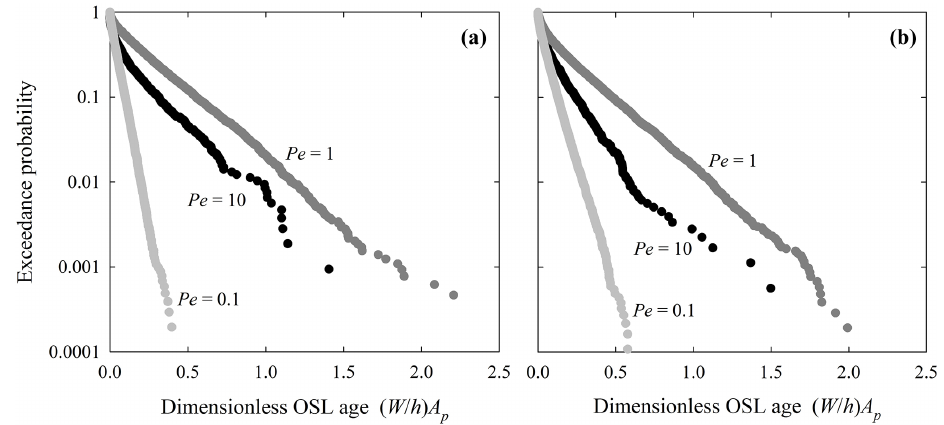
Figure 10. Exceedance probability plots of dimensionless particle OSL age ˆ A p = ( W/h ) A p for (a) uniform mixing and (b) nonuniform mixing for Péclet numbers Pe = 10, 1 and 0.1.